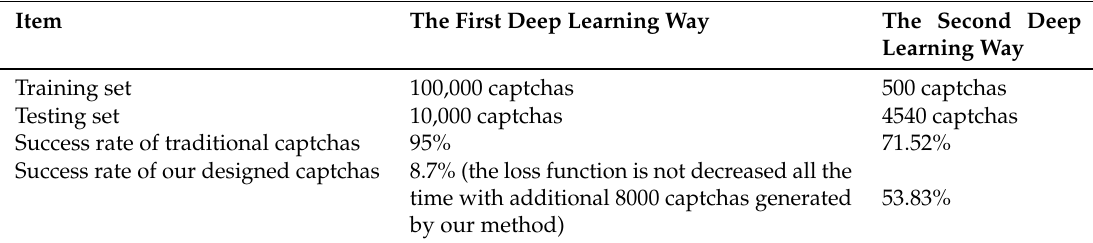
Table 3. Brief summary of the above experiments.